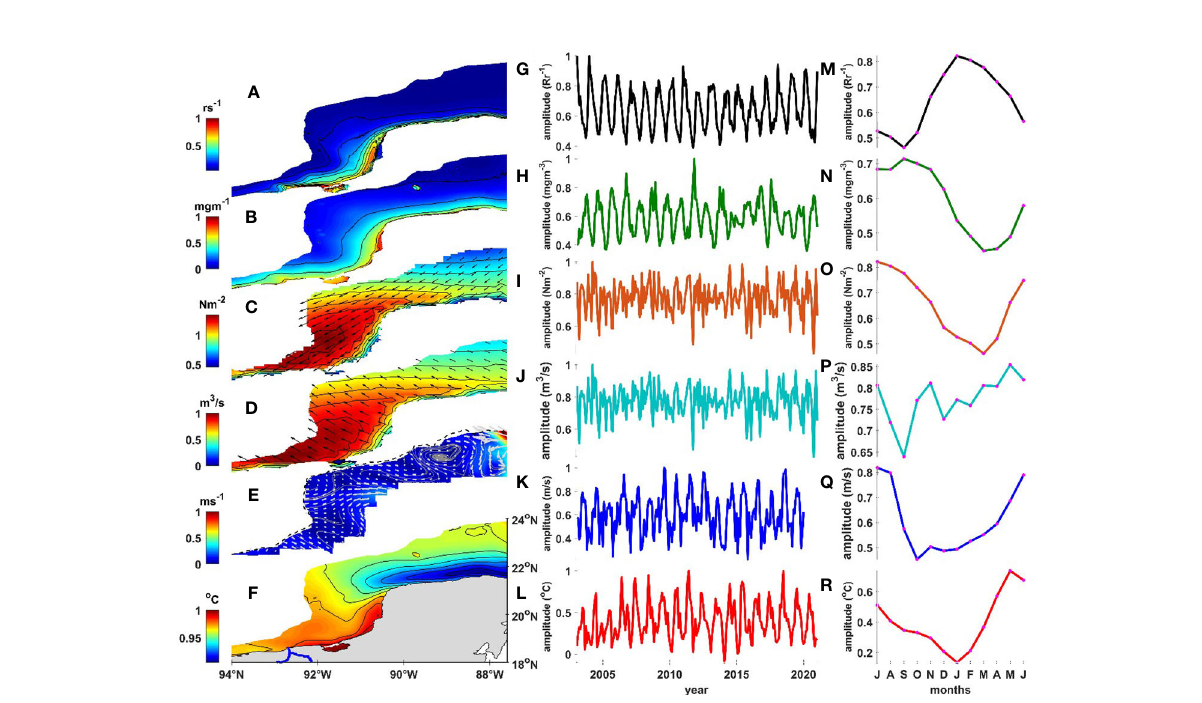
FIGURE 8 Spatial structure of the fi rst mode of the Empirical Orthogonal and Complex Functions of (A) Turbidity (Rrs555), (B) Chlorophyll, (C) Wind Effort, (D) Meridional Ekman Transport, (E) Velocity Geostrophic and (F) SST. Temporal structures and climatology of (G, M) Turbidity (Rrs555) in black line, (H, N) Chlorophyll in green line, (I, O) Wind effort in brown line, (J, P) Meridional Ekman transport in light blue line, (K, Q) Velocity Geostrophic on blue line, (L, R) SST on the red line. Climatology of temporary